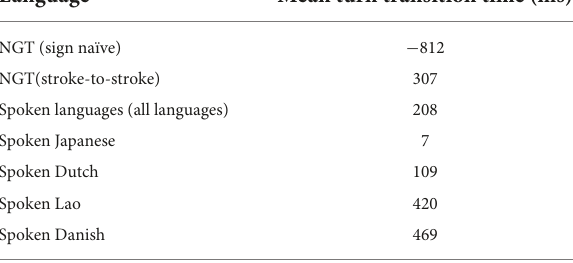
TABLE 4 Turn timing in Sign Language of the Netherlands (NGT) versus spoken